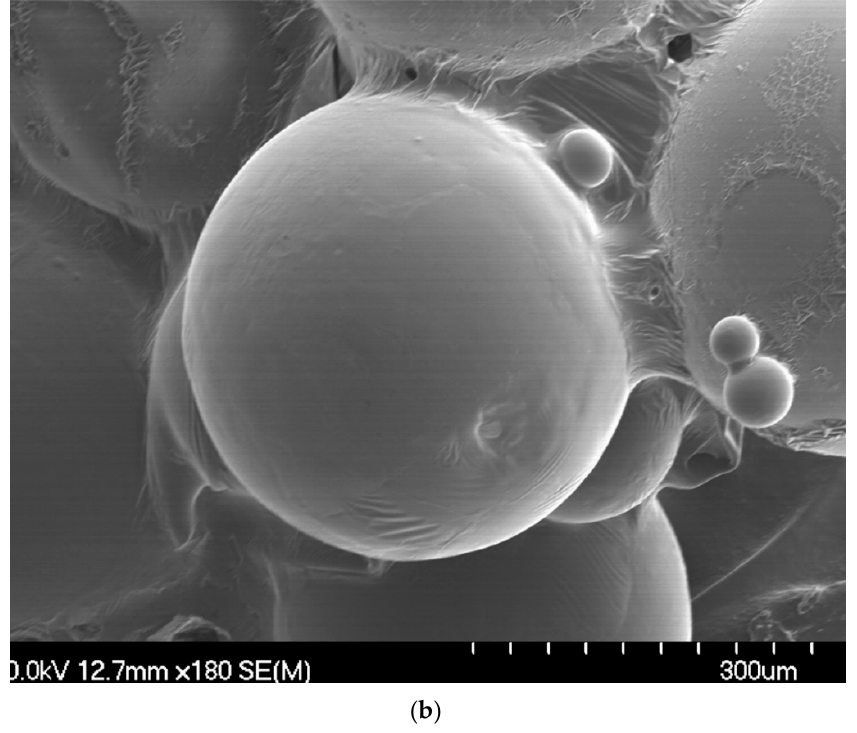
Figure 2. ( a ) Optical microscope images and ( b ) SEM image of microcapsules synthesized in a microfluidic device. Reproduced with permission from [57], IDEALS, copyright 2015.